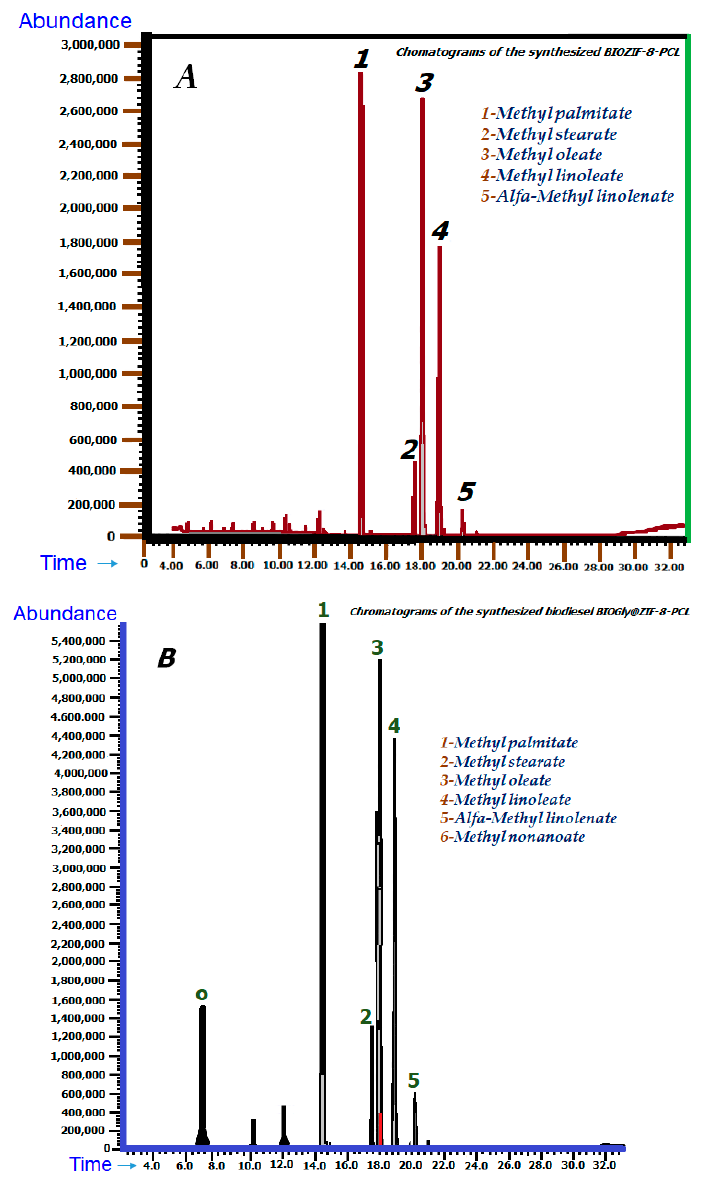
Figure 8. Chromatograms of the synthesized biodiesel: ( A ) BIOZIF-8-PCL and ( B ) BIOGly@ZIF-8-PCL.